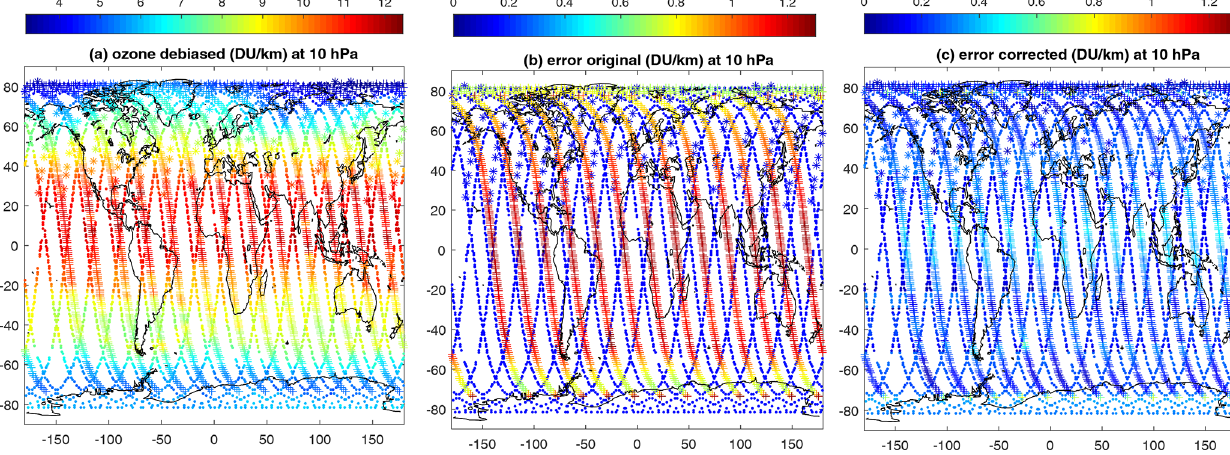
Figure 7. Debiased ozone at 10hPa for 1 September 2018 (a) , corresponding original uncertainties (b) , and corrected uncertainties (c) . MLS data are indicated by dots, OSIRIS by stars, and OMPS by